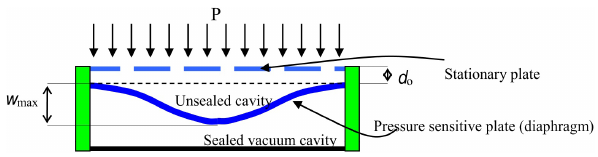
Figure 10. Schematic diagram of the proposed capacitive pressure sensor.